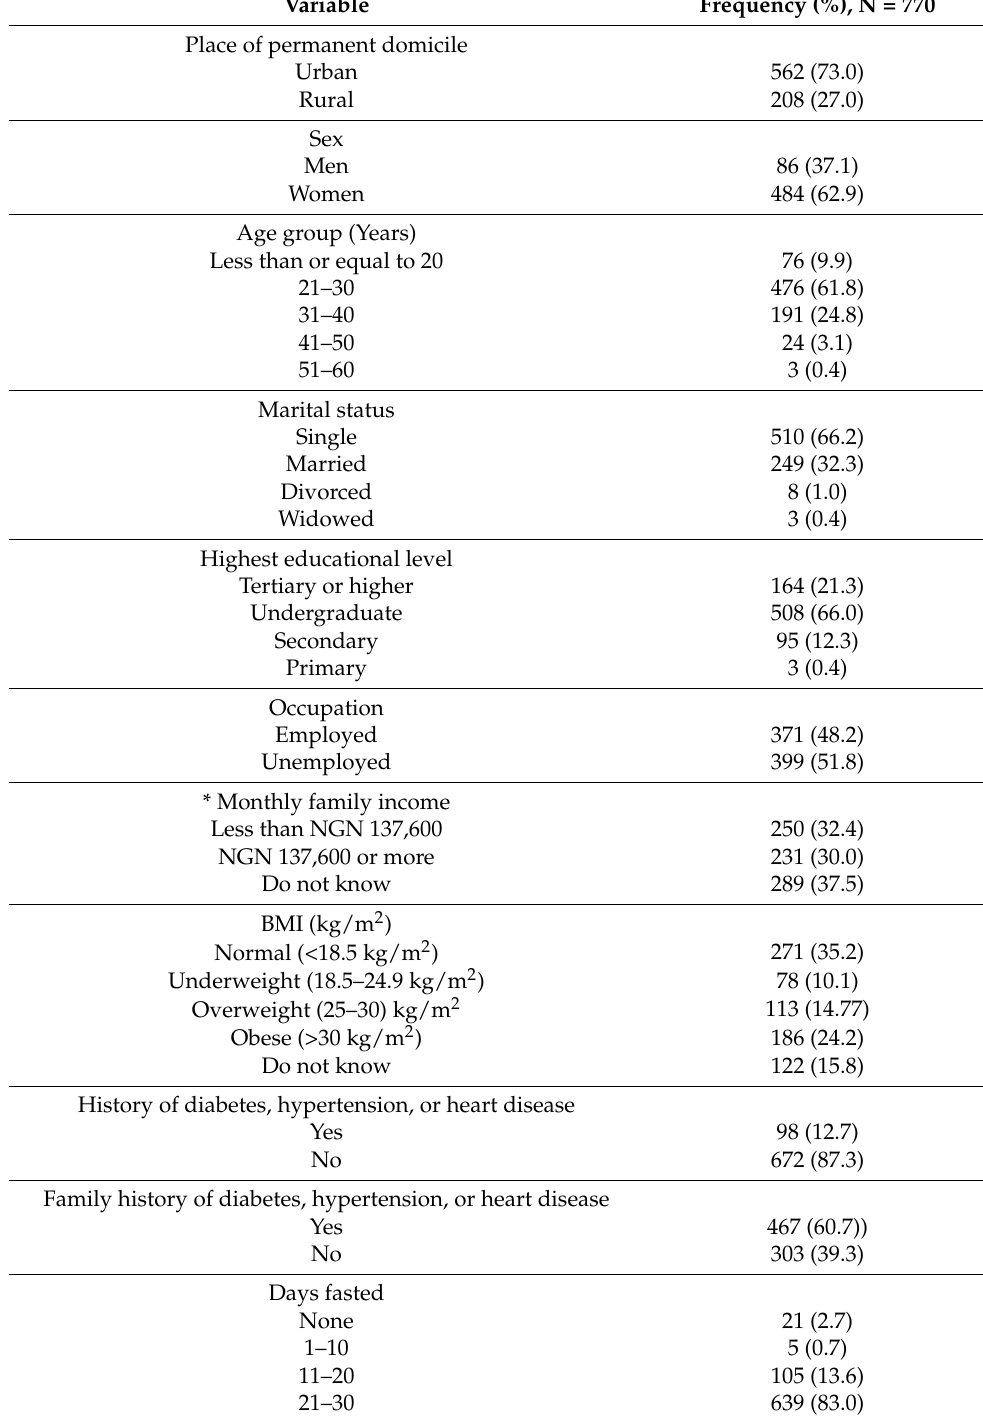
Table 1. Background characteristics of study